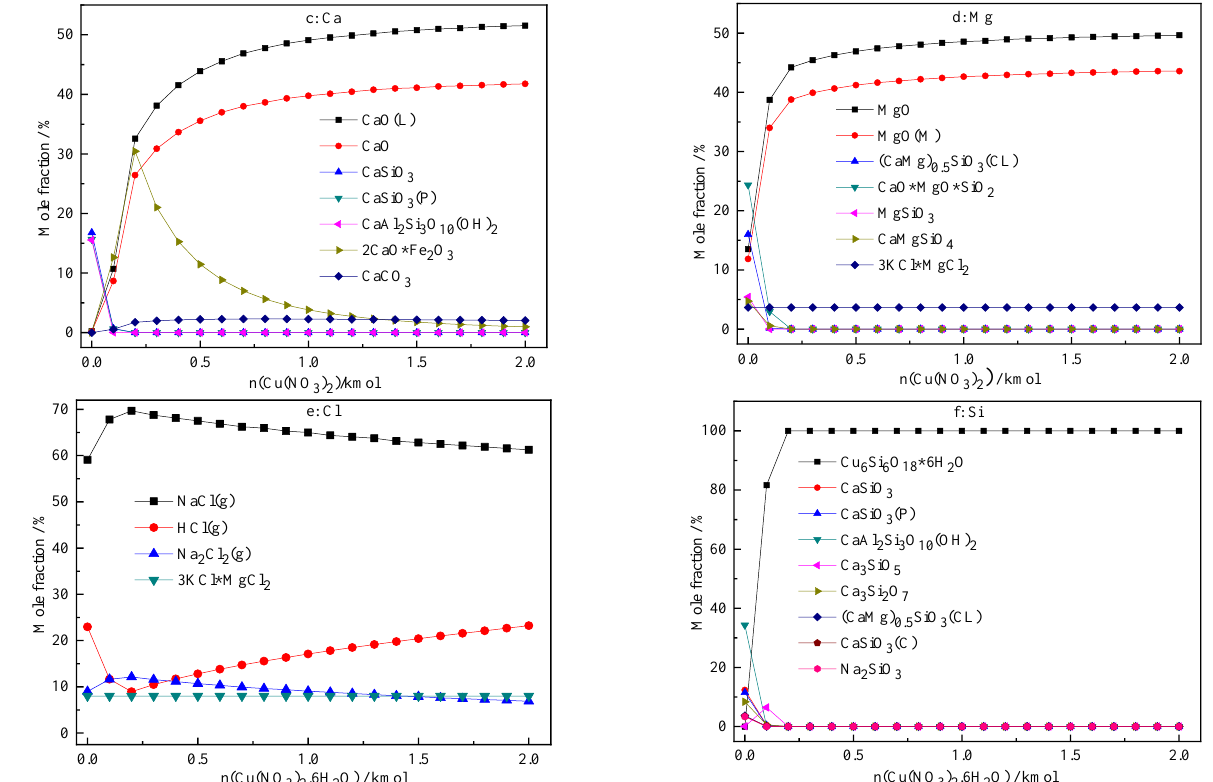
Figure 7. Effect of the amount of Cu(NO 3 ) 2 addition on the migration and transformation of main elements in ash. ( a ): Na, ( b ): K, ( c ): Ca, ( d ): Mg, ( e ): Cl, ( f ): Si. The asterisk in the chemical formula shows that the molecules or species are attached with each other as independent species, similarly hereinafter.